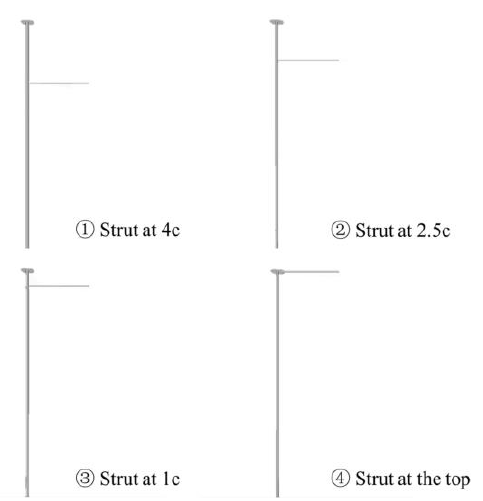
Figure 20. Supporting strut at different heights.